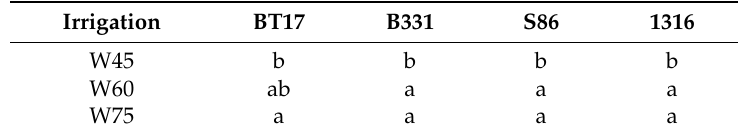
Table 5. Tukey’s HSD significant difference test results of the means of stand volume increments under different irrigation levels for each clone. Irrigation BT17